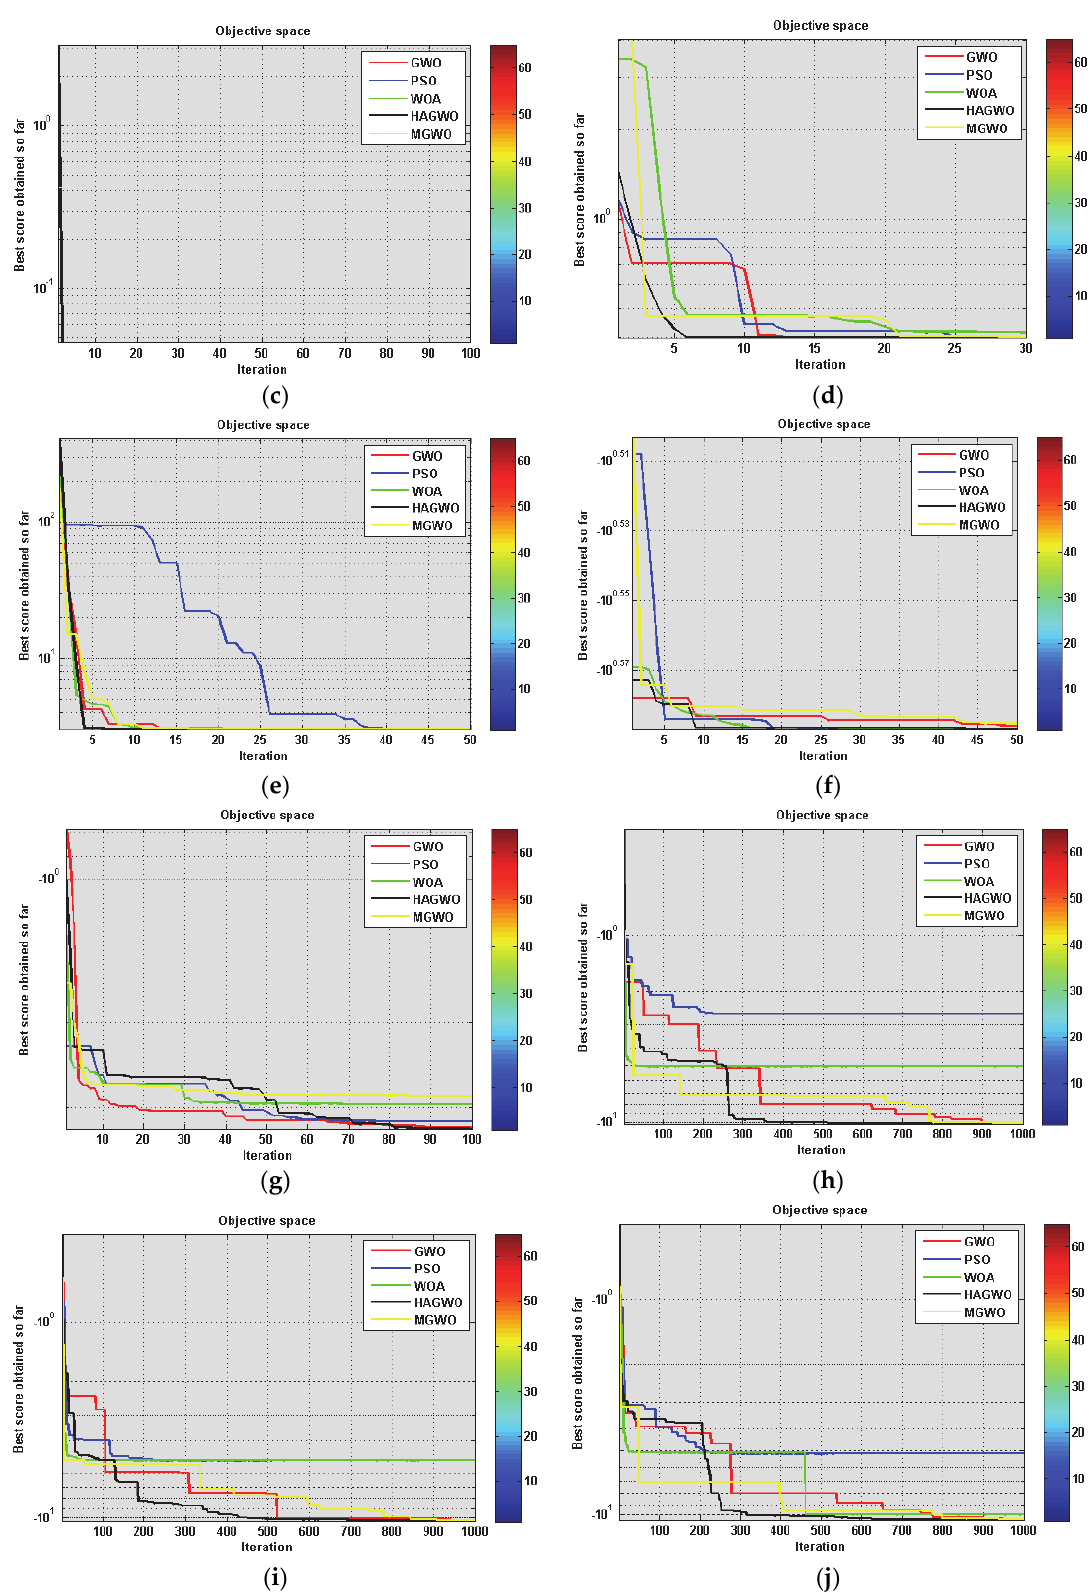
Figure 4. Convergence Curve of PSO, GWO, WOA, MGWO and HAGWO variants on Fixed-dimension multimodal benchmark functions.